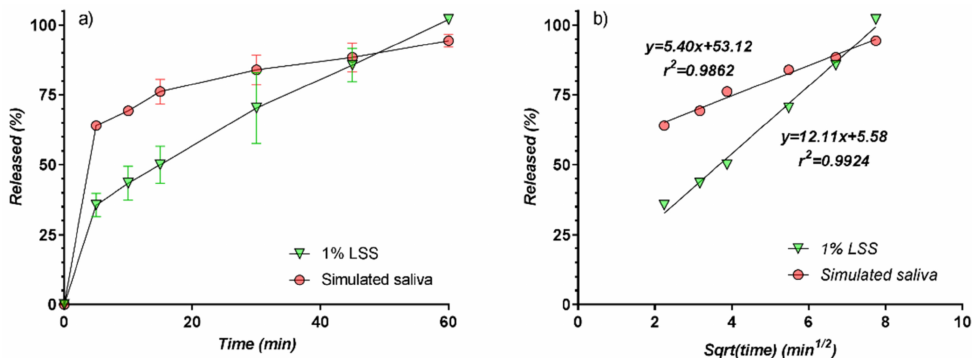
Figure 9. ( a ) In vitro release profiles of CBZ from the chewable tablets containing the CBZ- β -CD complex; ( b ) release curves as function of square root of